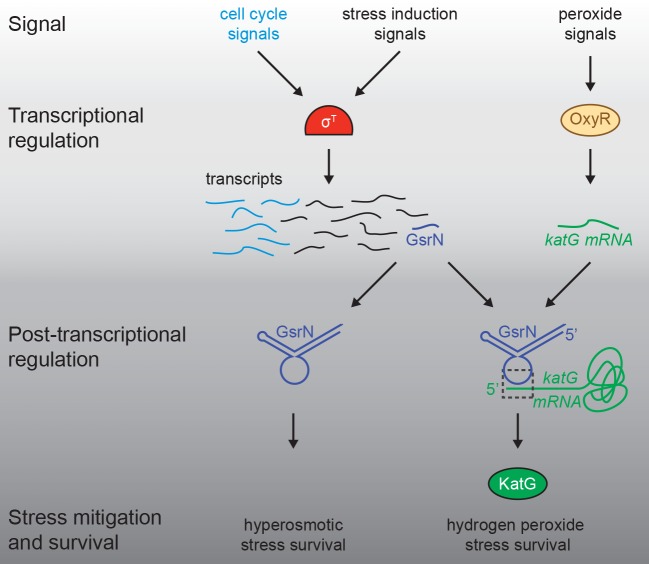
Regulatory architecture of the Caulobacter stress response systems.Expression of the GSR EcfG-sigma factor, sigT (σT), and select genes in the GSR regulon is regulated as a function cell cycle phase. σT-dependent transcription can be induced by certain signals (e.g. hyperosmotic stress), but is unaffected by hydrogen peroxide. Transcription of the sRNA, GsrN, is activated by σT, and the cell cycle expression profile of gsrN is highly correlated with sigT and its upstream regulators. Transcription of the catalase/peroxidase katG is independent of σT. GsrN dependent activation of KatG protein expression is sufficient to rescue the peroxide survival defect of a ∆sigT null strain. GsrN convenes a post-transcriptional layer of gene regulation that confers resistance to peroxide and hyperosmotic stresses.